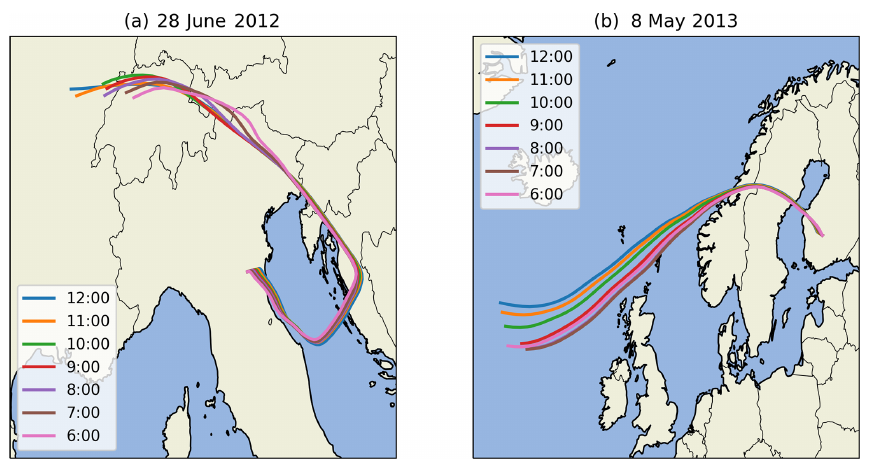
Figure 2. Air mass backward trajectories to (a) SPC during the morning of 28 June 2012 and (b) HTL during the morning of 8 May 2013. The legend shows the hour of air mass arrival in UTC. The arrival altitude was set to 100m above ground.